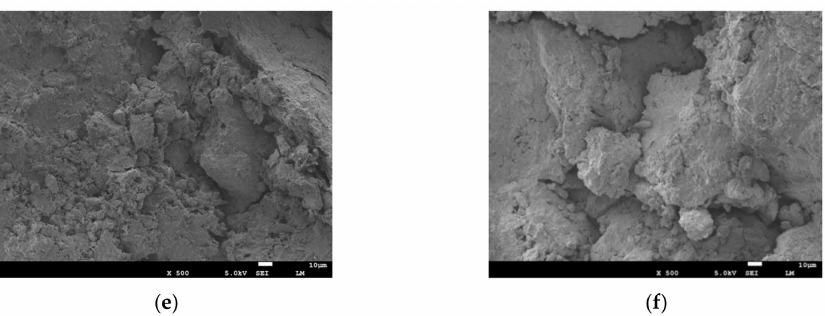
Figure 19. SEM analysis of carbonaceous shale calving resistance test: ( a ) the initial rock samples; ( b ) initial rock sample with magnification of 2000 times; ( c ) the 1st dry–wet cycle; ( d ) the 1st dry–wet cycle with magnification of 2000 times; ( e ) the 3rd cycle; ( f ) the 5th